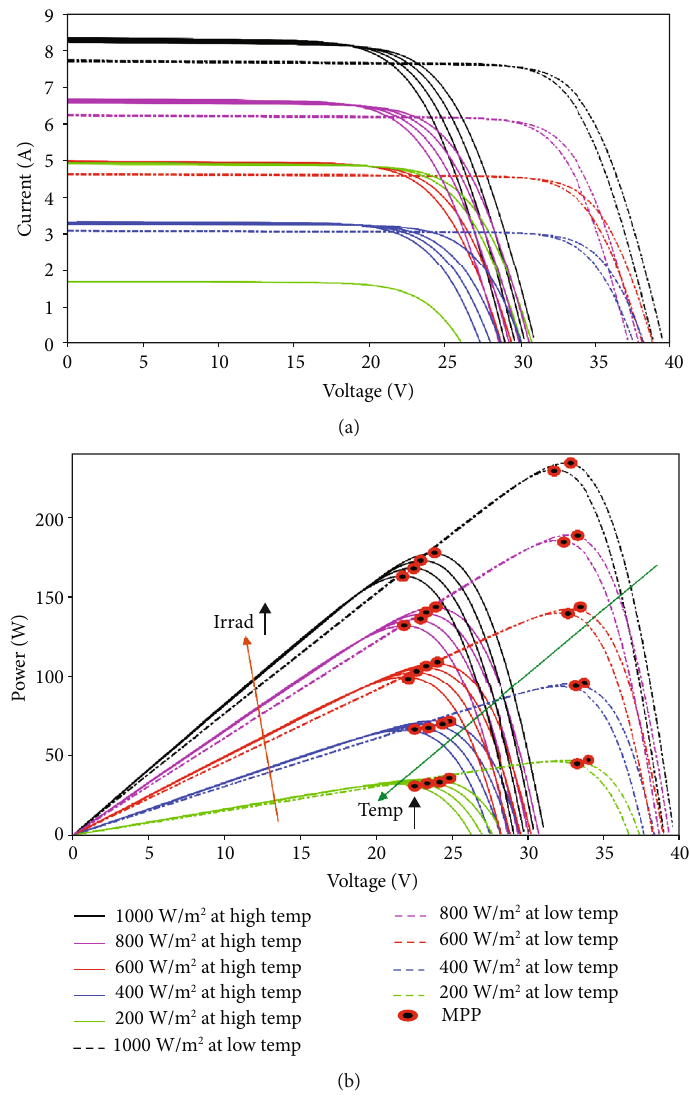
Figure 1: PV module output characteristics with di ff erent temperature variability e ff ects and under di ff erent solar radiation levels: (a) I – V characteristics and (b) P – V